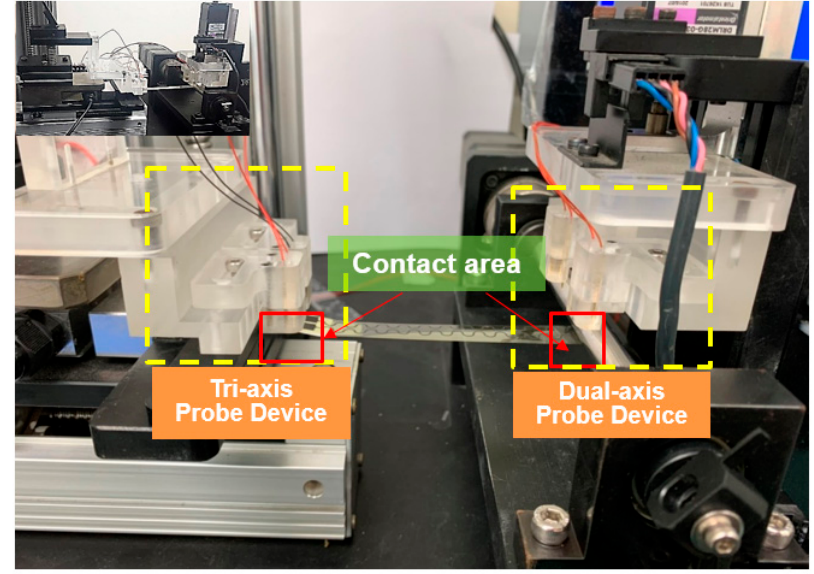
Figure 4. Probe devices installed on the real-time electrical measurement system.